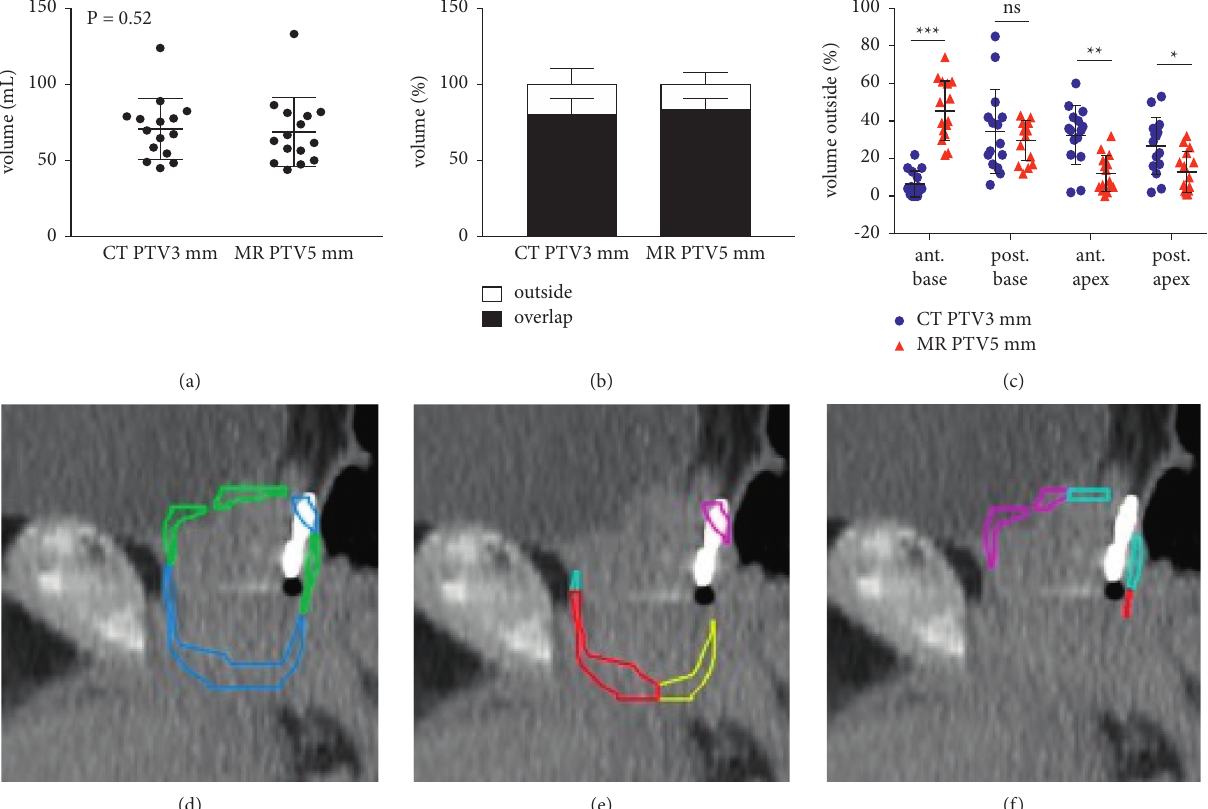
Figure 3: Discordance between CT and MR prostate contour by quadrant. Absolute volume (a) and percent overlap (b) of CT PTV3mm and MR PTV5mm are shown. (c) Percent volume by quadrant where the CT PTV3mm extends outside MR PTV5mm is shown in blue, and percent volume by quadrant where the MR PTV5mm extends outside the CT PTV3mm is shown in red. Graphical representation of regions of discordance between CT PTV3mm and MR PTV5mm is shown in the panels. (d) Volume in green shows areas were the MR PTV5mm extends outside the CT PTV3mm, and volume in blue shows areas were the CT PTV3mm extends outside the MR PTV5mm. (e) Location (by quadrant) where CT PTV3mm extends outside the MR PTV5mm is shown. (f) Location (by quadrant) where MR PTV5mm extends outside the CT PTV3mm is shown. All panels show mean ± standard deviation. In panels A and C, individual values for all 15 subjects are shown. ∗ P < 0.05, ∗∗ P < 0.01, and ∗∗∗ P < 0.001 by two-tailed paired Student’s t -test or signed rank